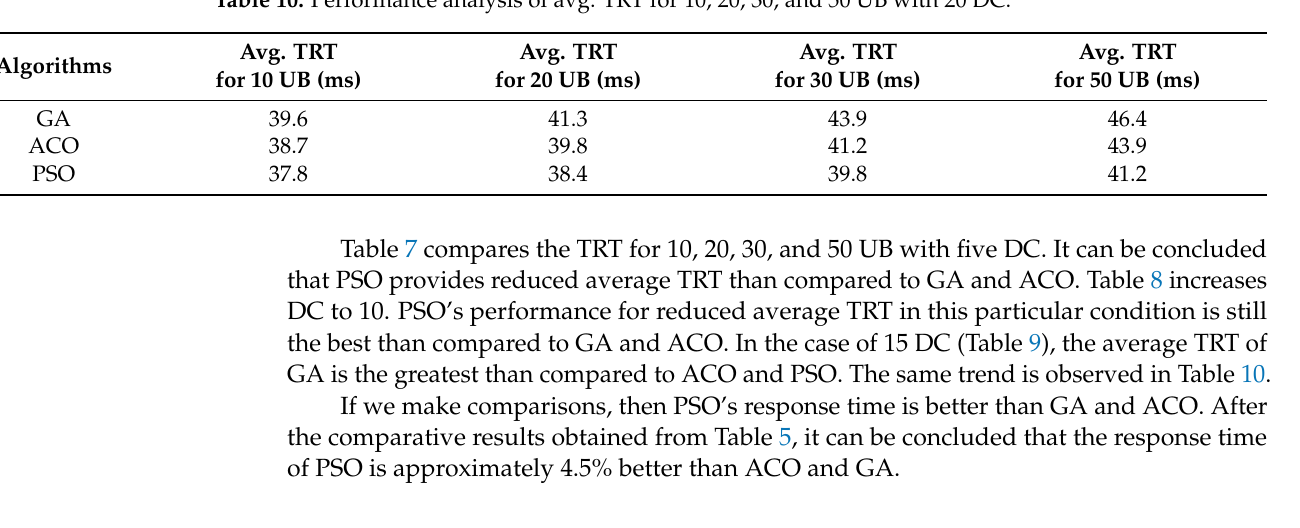
Table 10. Performance analysis of avg. TRT for 10, 20, 30, and 50 UB with 20